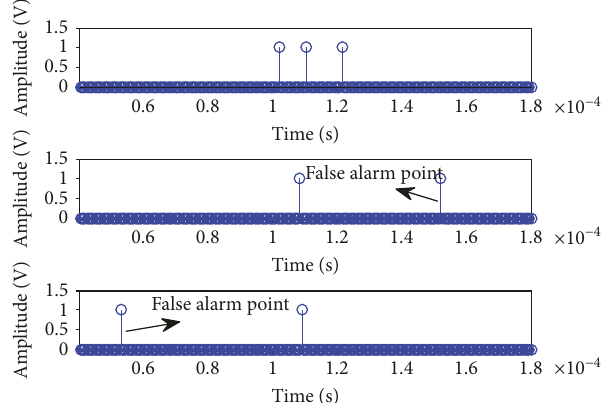
Figure 8: Results of transmitting the LFM signal and signal I ( K = 3 , q = 2 ) and signal II ( K = 3 , q 1 detection).